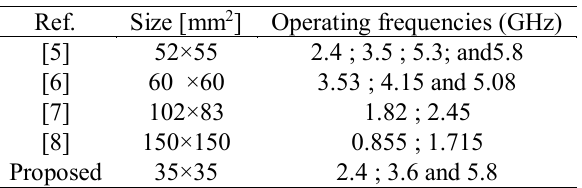
Figure 11 : Measured and simulated reflection coefficients of the proposed antenna.